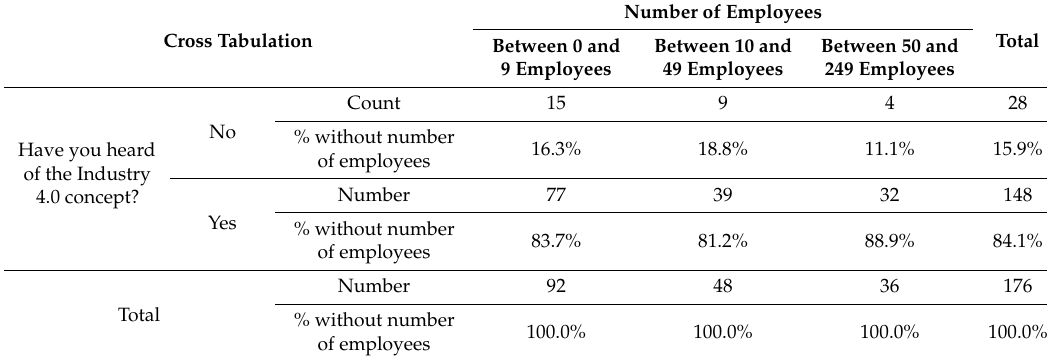
Table 1. Contingency table for knowing the Industry 4.0 concept in relation to enterprise size. Cross Tabulation